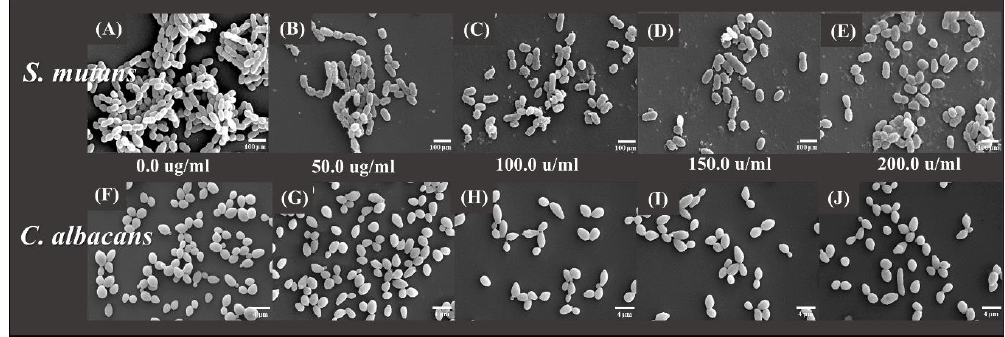
Figure 4. Field-emission scanning electron microscope images of S. mutans on ( A ) 0, ( B ) 50, ( C ) 100, ( D ) 150, and ( E ) 200 μ g/mL of Cnidium officinale (CO) extracts (scale bar = 100 μm) and C. albicans on ( F ) 0, ( G ) 50, ( H ) 100, ( I ) ( F ) 0, ( G ) 50, ( H ) 100, ( I ) 150, and ( J ) 200 µ g / mL of CO extracts (scale bar = 4 µ m). 150, and ( J ) 200 μ g/mL of CO extracts (scale bar = 4 μm) .